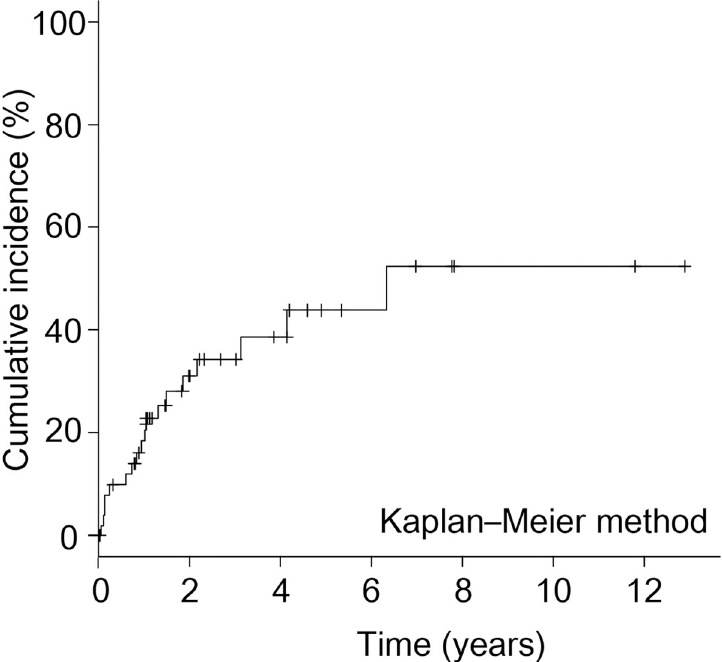
Fig 1. Cumulative incidence of pouchitis. The incidence of pouchitis was 19.2%, 32.6%, and 45.9% at 1, 2, and 5 years, respectively. https://doi.org/10.1371/journal.pone.0241322.g001 Table 1. Baseline characteristics of the study population.